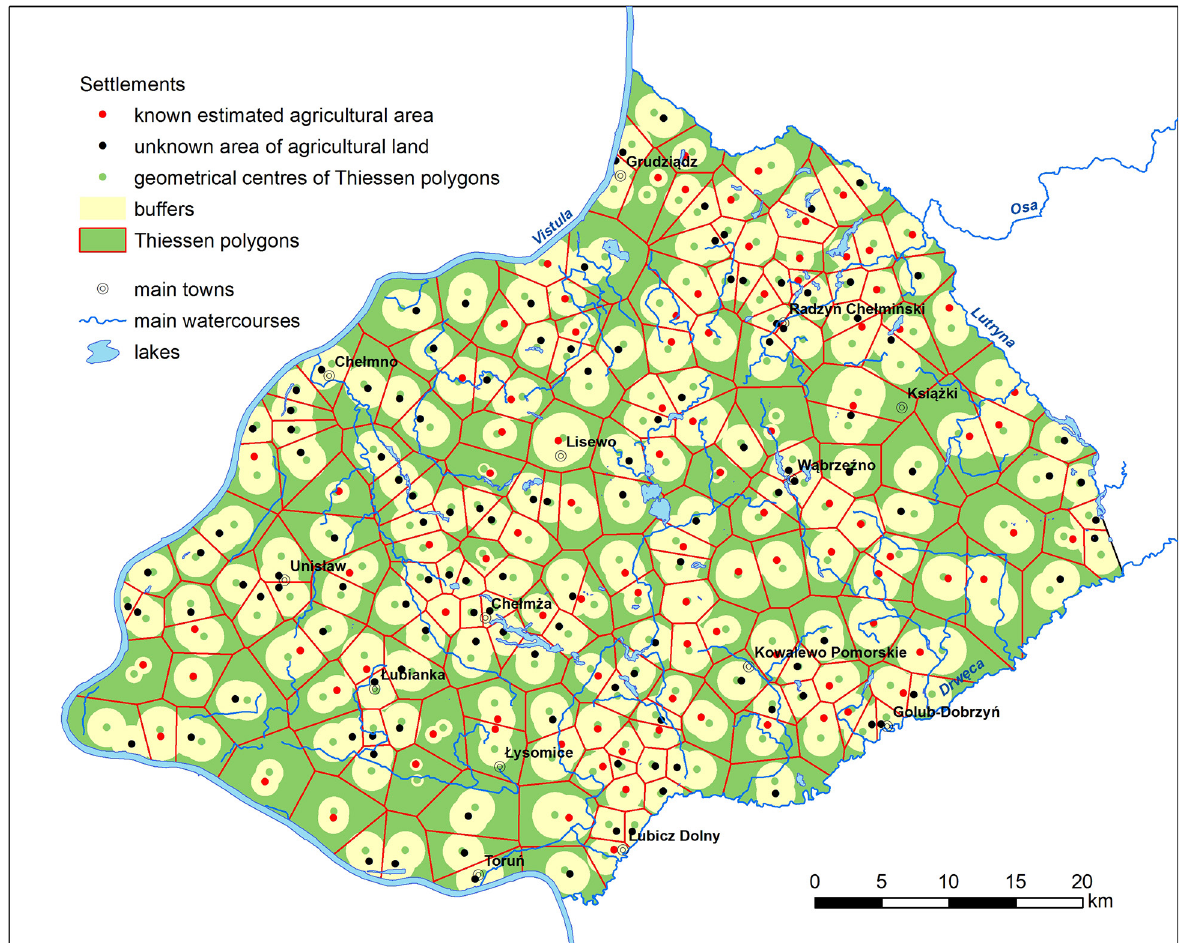
Fig. 7. Hypothetical extent of lands used for